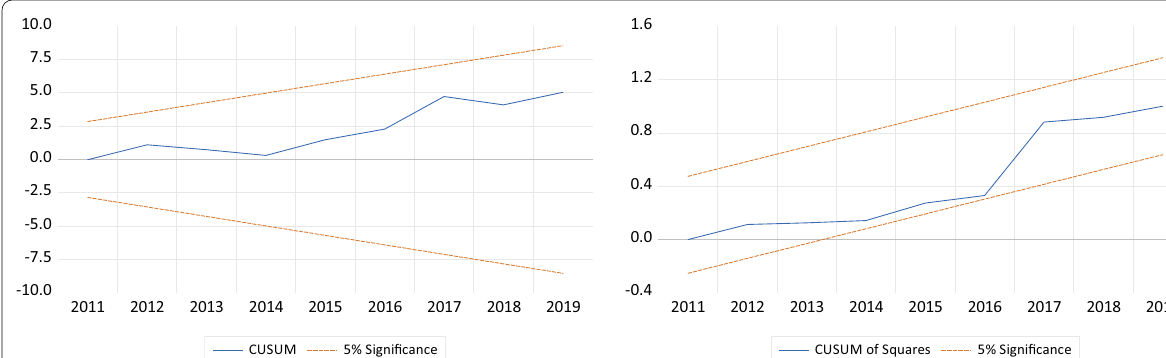
Fig. 5 CUSUM and CUSUMSQ long-run analysis stability tests of model 2